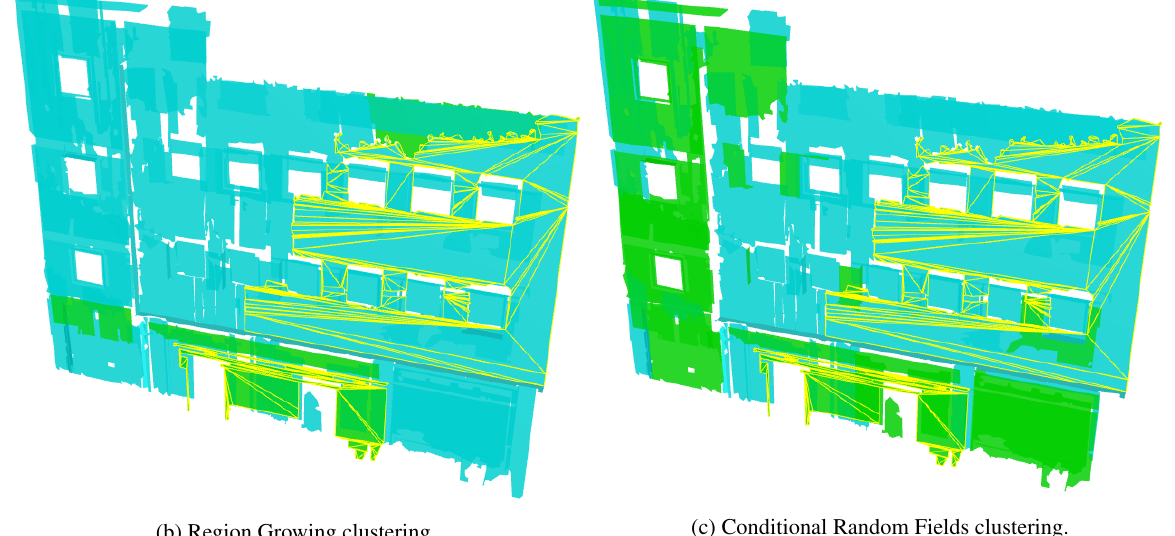
Figure 5: Comparison between the results of the proposed CRF clustering algorithm and a conventional region growing algorithm. The seed nodes are represented in yellow and the walls are colored according to their respective